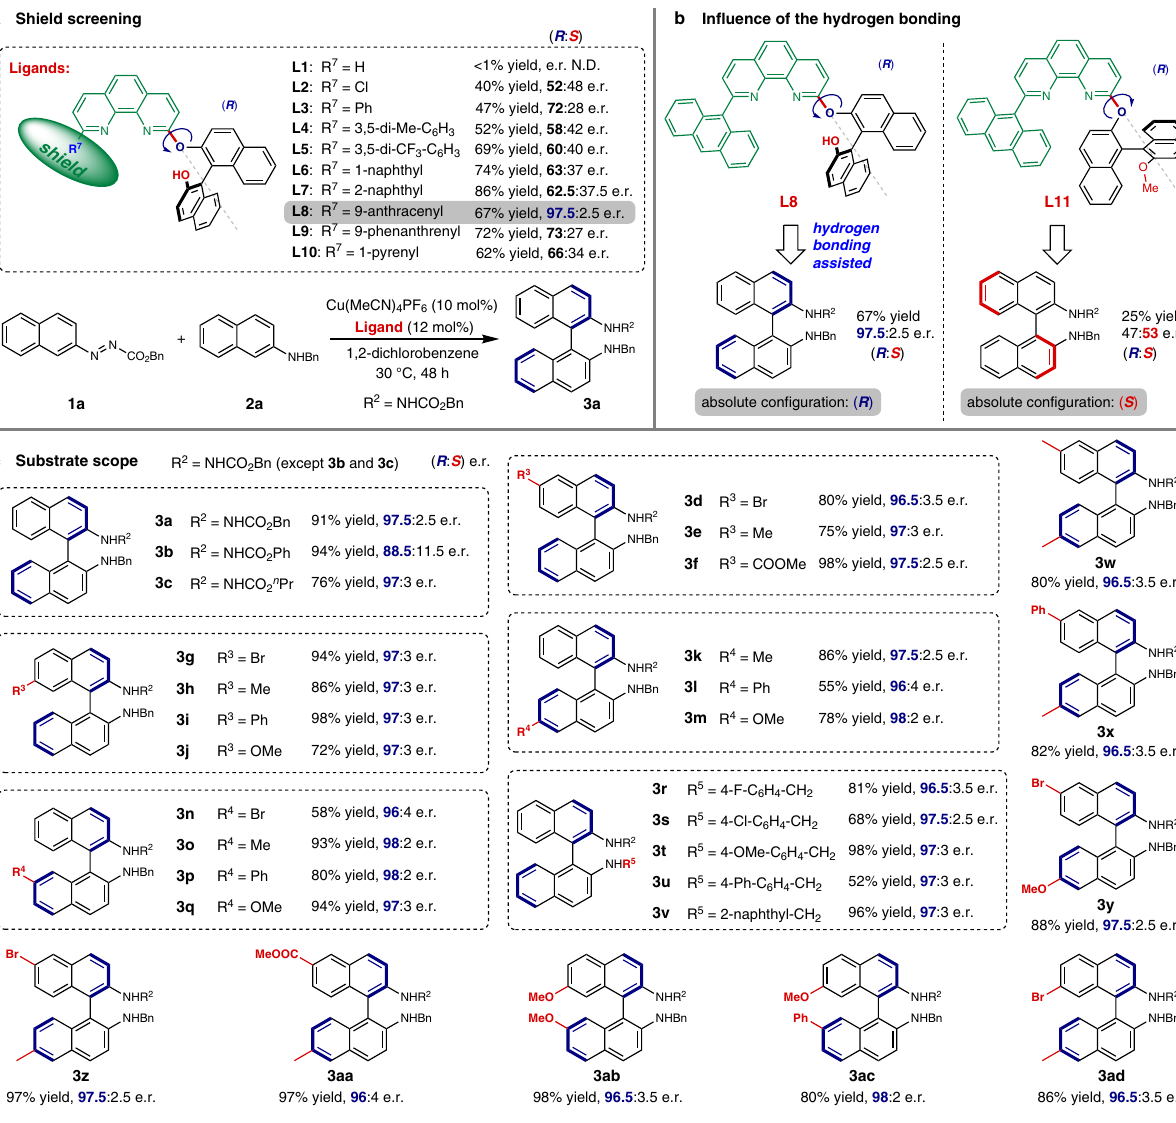
propyl; Bn, benzyl; Ph, phenyl. The absolute con fi guration of all the products with blue thick bonds is R